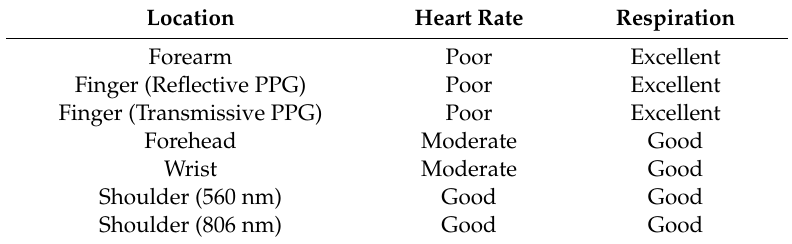
Table 1. Measurement locations used by Nilsson et al. [18] showing the relationship between location and ability to measure heart rate and